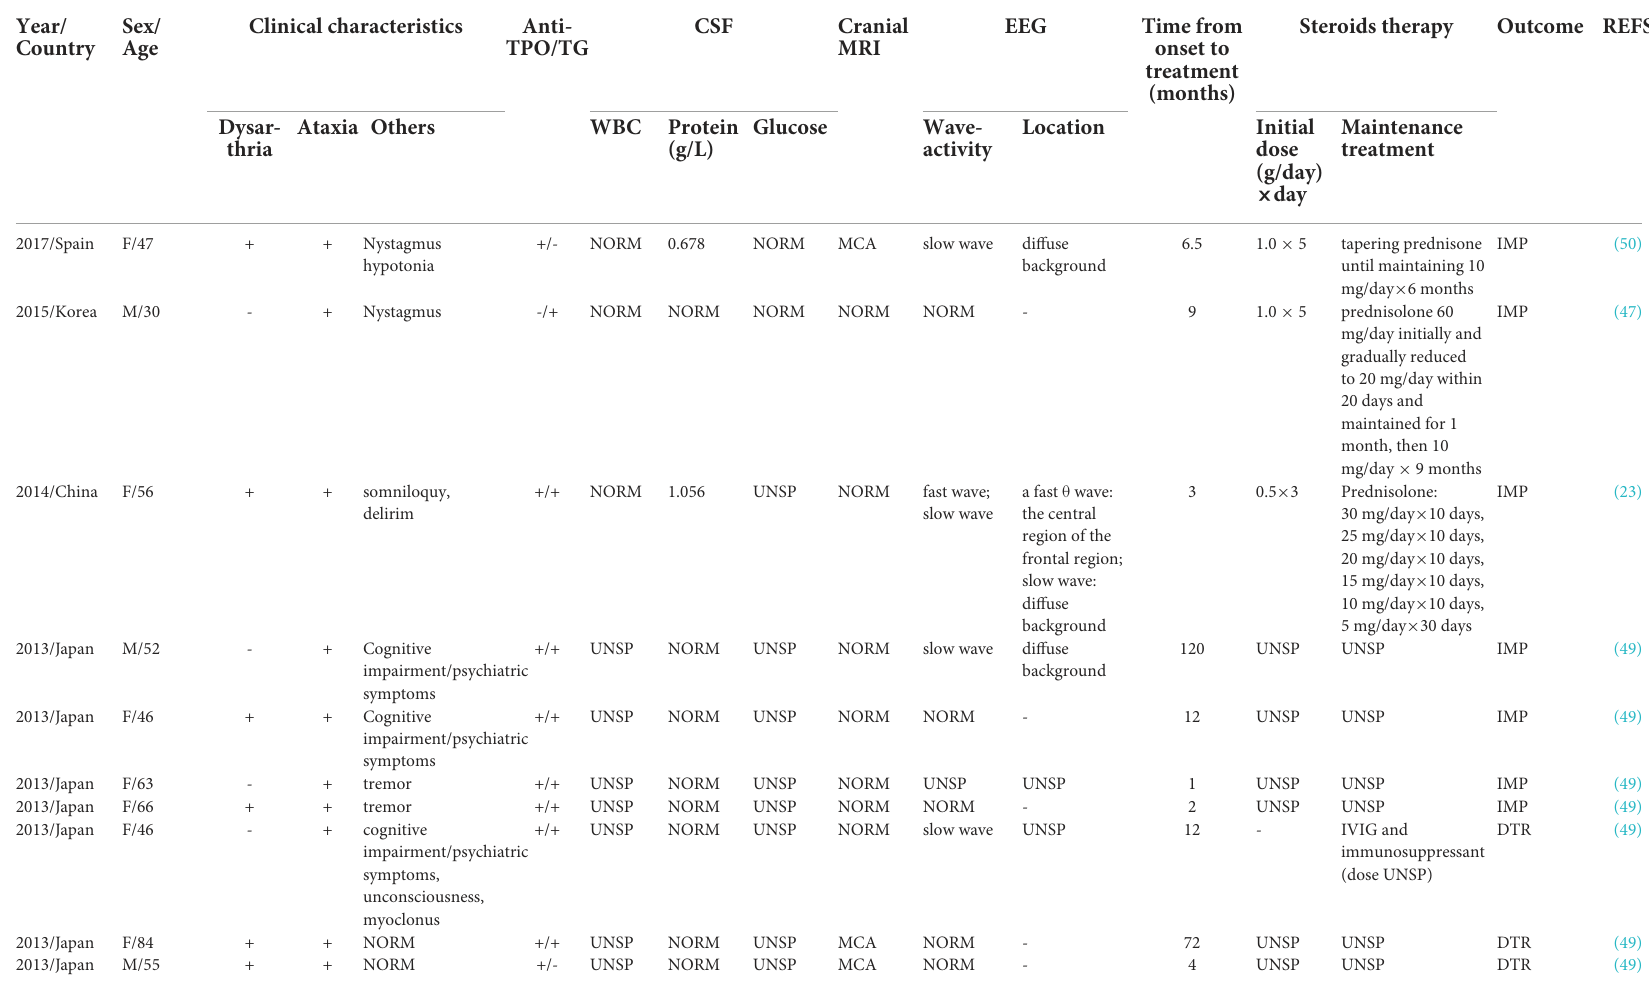
TABLE 1 The clinical characteristics of cases of HE with cerebellar ataxia as the main